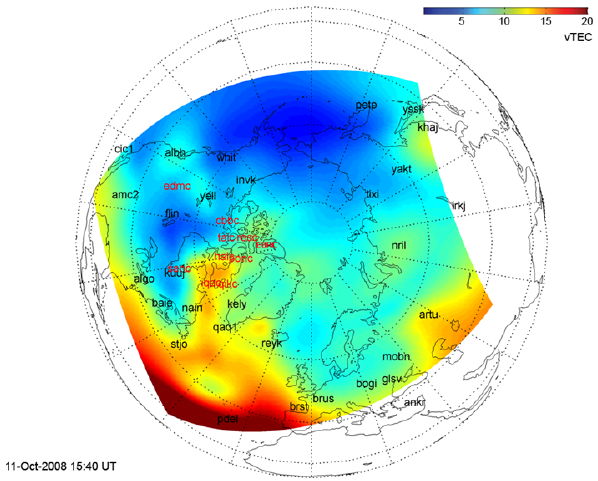
Fig. 6. Vertical TEC map showing a tongue of ionization and patches convected into the polar cap.